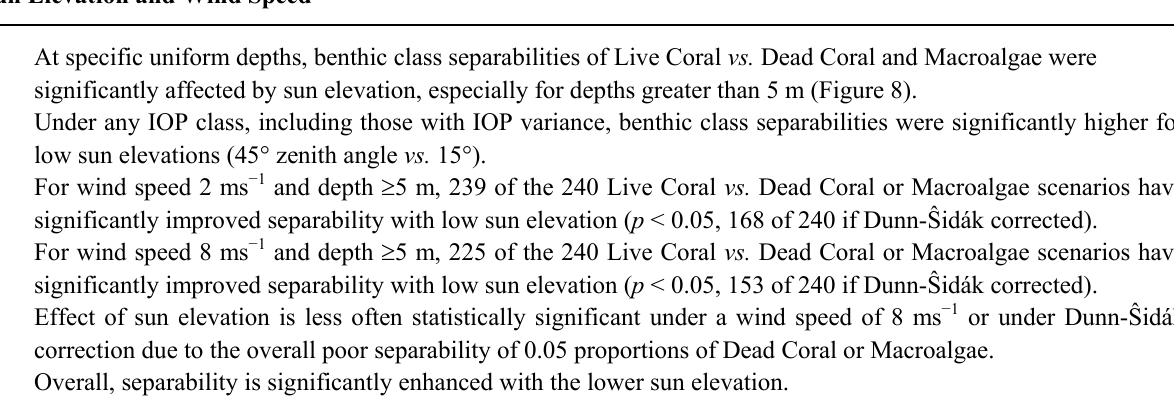
Table 4. Summary of the effect on separability of the individual sensitivity analysis factors. Sun Elevation and Wind